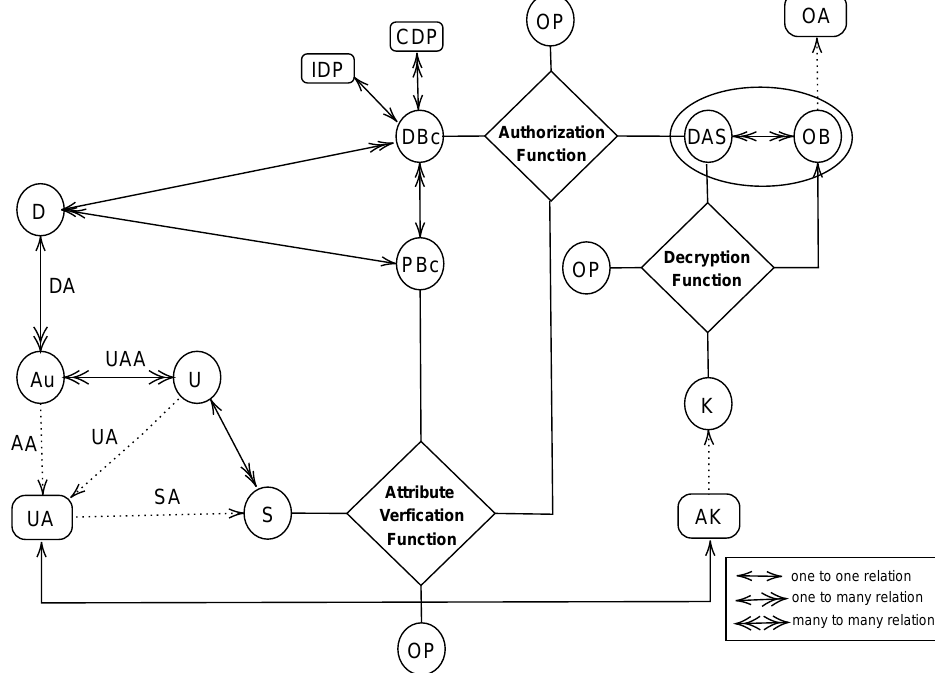
Figure 3. HMBAC access model: element sets and